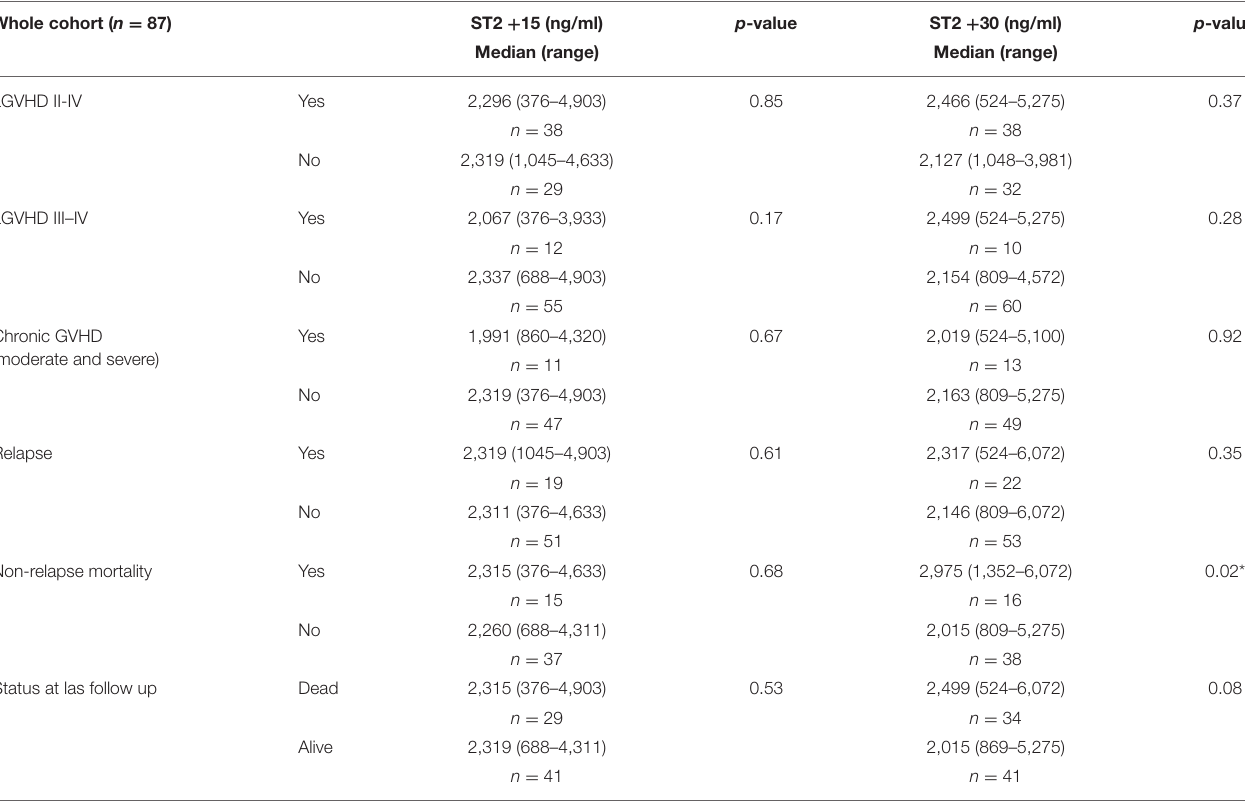
TABLE 2 | Association between ST2 levels at day + 15 and + 30 and GVHD (acute and chronic), NRM, relapse, and OS in the whole cohort ( n = 87). Whole cohort ( n = 87) ST2 + 15 (ng/ml) p -value ST2 + 30 (ng/ml) p -value Median